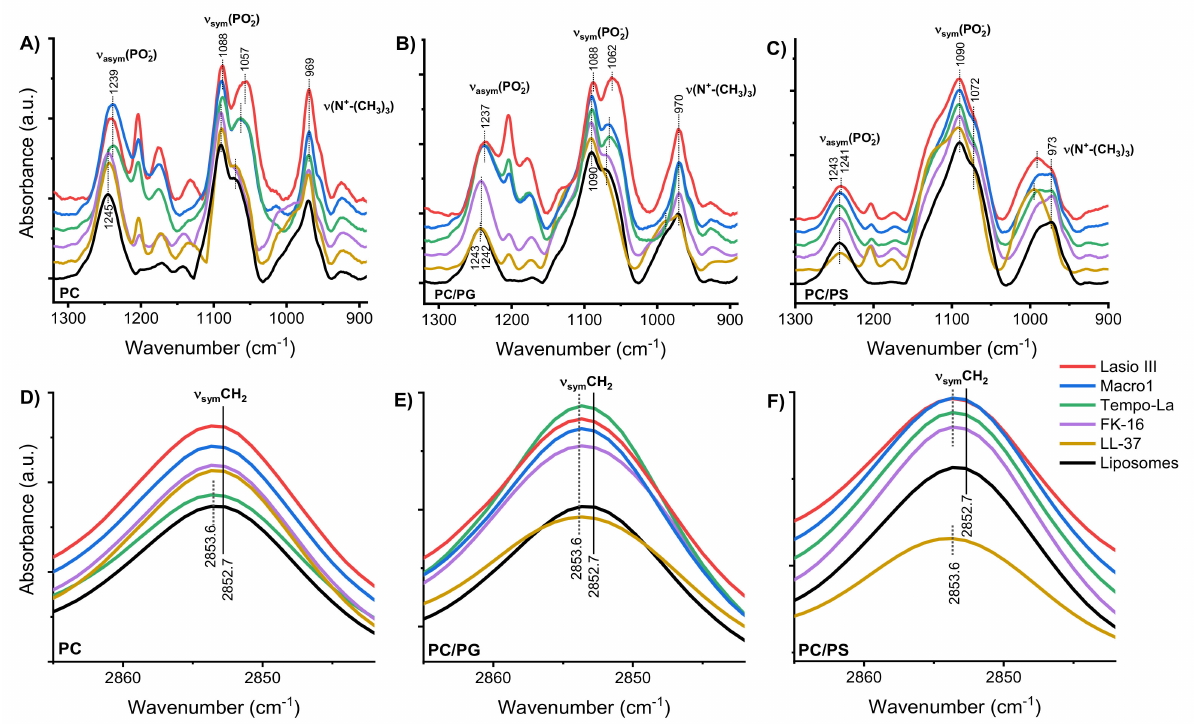
Figure 2. Membrane interaction studied by infrared spectroscopy (IR). Representative infrared spectra in the lipid head- group region of ( A ) PC, ( B ) PC/PG, and ( C ) PC/PS membranes alone and upon interaction with the studied peptides. The analysed vibrational modes, namely ν asym (PO 2 − ), ν sym (PO 2 − ), and ν (N + -(CH 3 ) 3 ), refers to the asymmetric and symmetric phosphate stretching, and to the asymmetric choline stretching, respectively. Representative infrared spectra of the acyl CH 2 group region of ( D ) PC, ( E ) PC/PG, and ( F ) PC/PS membranes alone and upon interaction with the studied peptides. Peptide and lipid concentrations were 80 µ M and 1.27 mM, respectively, for all the peptides except for LL-37 which was 40 µ M and 0.635 mM, respectively, resulting in the same peptide-to-lipid